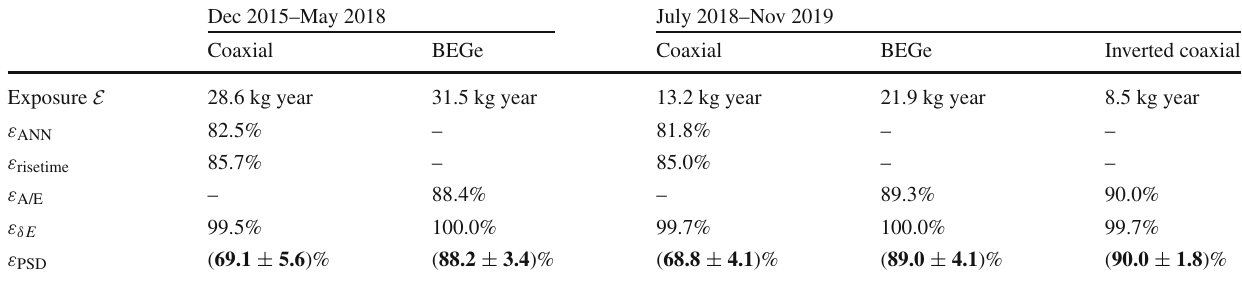
uncertainties are shown in bold; they are estimated via a MC sampling ofindividual values(seeTable3)andarethusdifferent fromtheproduct of the individual PSD methods efficiencies reported